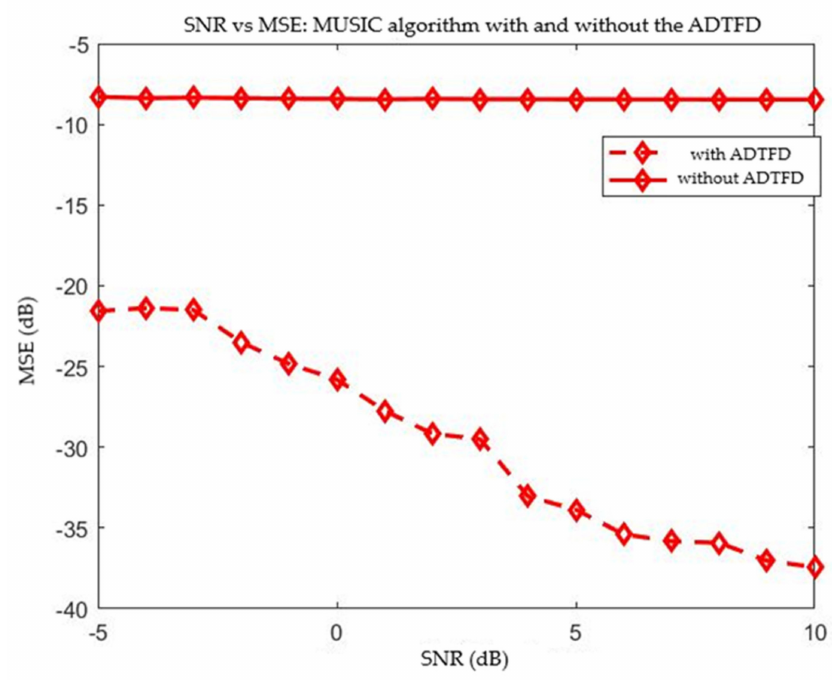
Figure 7. SNR vs. MSE plot of the MUSIC algorithm with and without ADTFD (solid line and the dashed line represents the cases without ADTFT and with ADTFD,